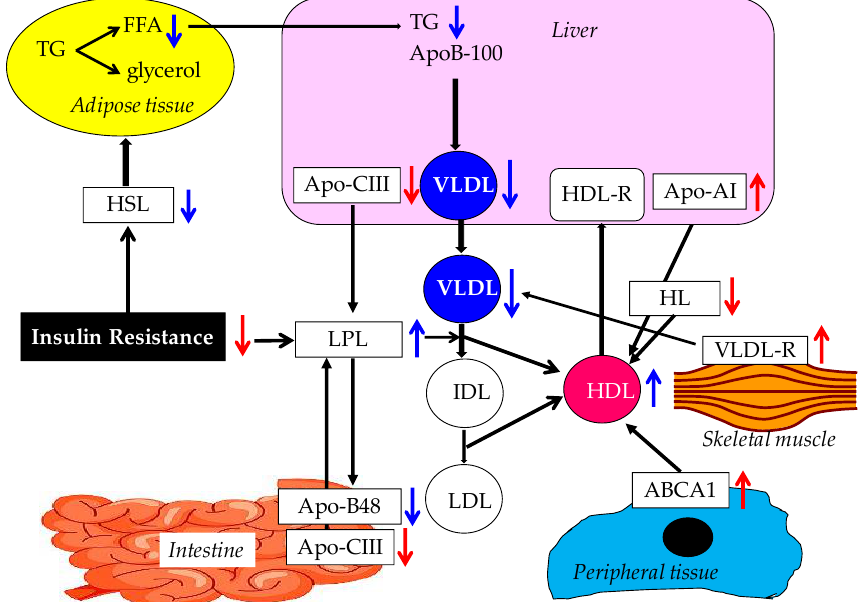
Figure 2. Possible mechanisms for the improvement of lipid metabolism by adiponectin. Red and blue arrows indicate direct and indirect lipid metabolism improving effects of adiponectin, respectively. ABCA1, ATP-binding cassette transporter A1; FFA, free fatty acids; HDL, high-density lipoprotein; HL, hepatic lipase; HSL, hormone-sensitive lipase; IDL, intermediate-density lipoprotein; LDL, low-density lipoprotein; TG, triglyceride; VLDL, very low density lipoprotein; VLDL-R, very low density lipoprotein-receptor.